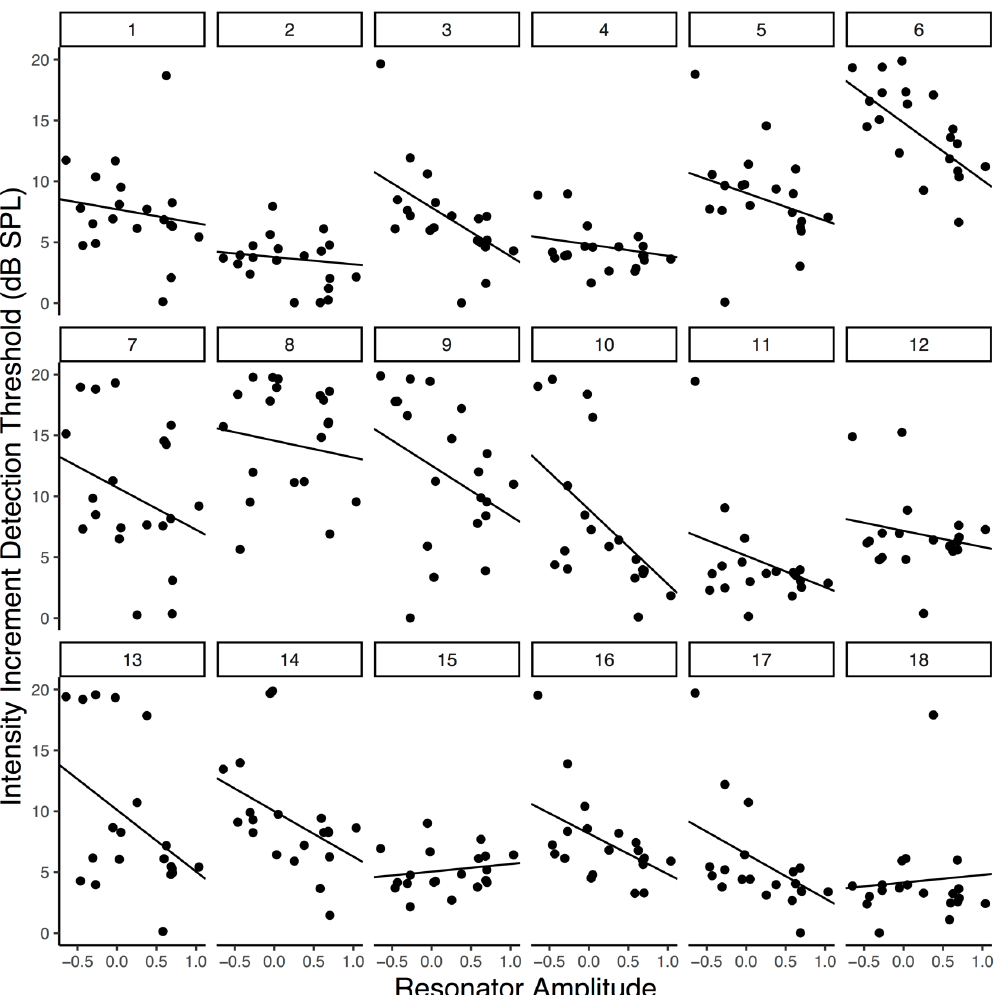
Figure 3. Increment detection thresholds as a function of averaged peak resonator level. Each panel is an individual participant’s data. Lines reflect participants’ slopes and intercepts as random effects in a mixed-effects